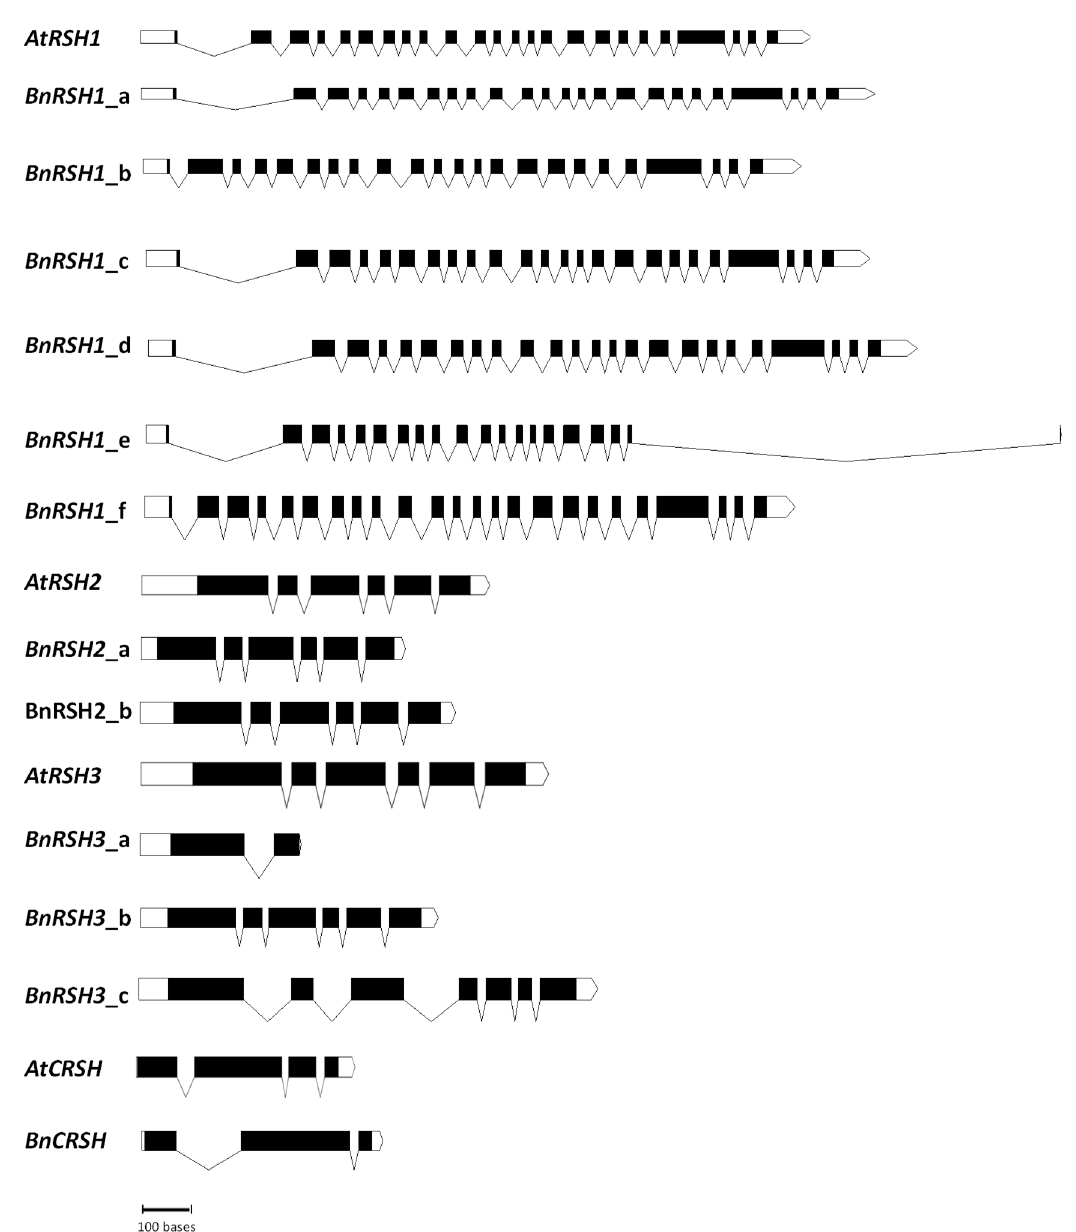
Figure 2. Intron-exon structure of RSH genes in A. thaliana and B. napus . White rectangles indicate UTRs, and black rectangles indicate coding sequence. Intron positions are marked by lines. The analysis was performed using the CIWOG tool.